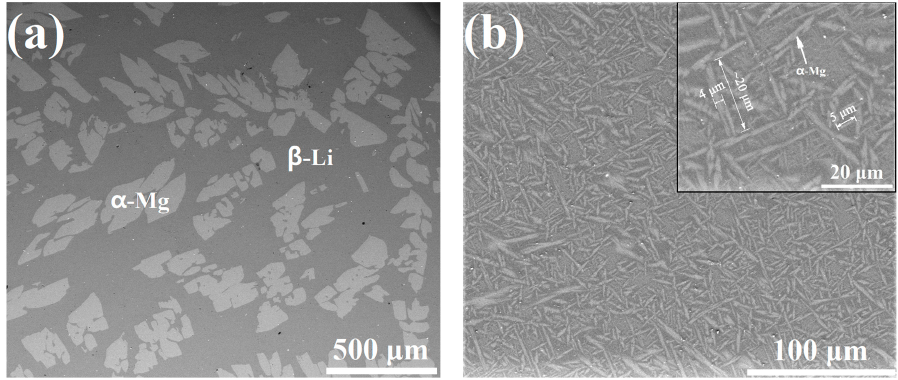
Figure 2. SEM microstructure of the Mg-9Li alloys. ( a ) Cast alloy; ( b ) solid-solution (SS) alloy.